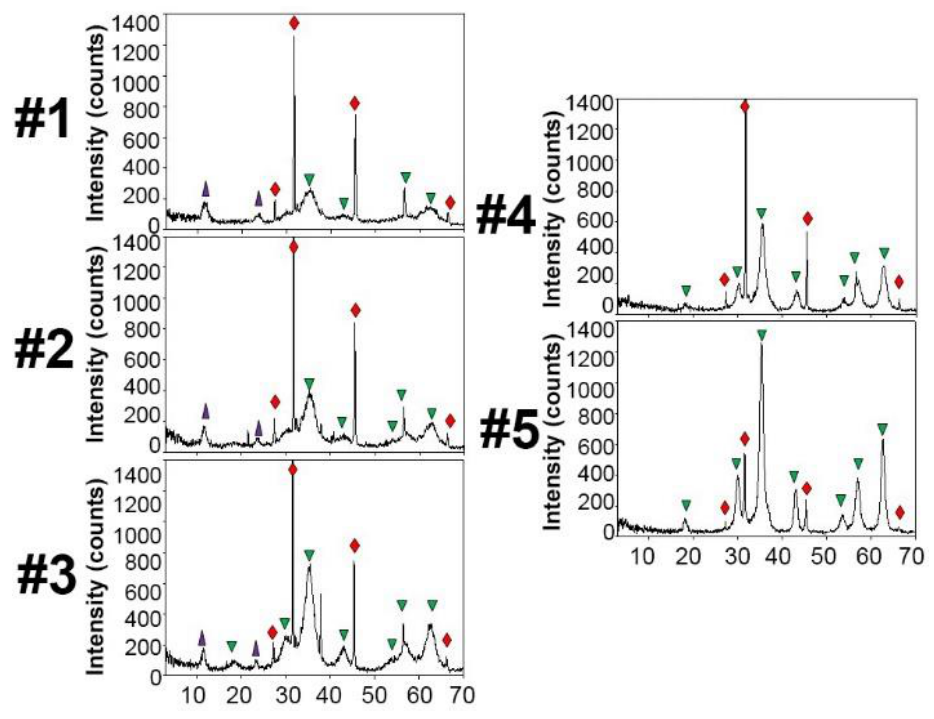
Figure 2. Powder X-ray diffraction (PXRD) patterns of samples #1–5. (MgAC), (NaCl halite, JCPDS-00-005-0628; JCPDS: Joint Committee on Power Diffraction Standard), and (Fe 3 O 4 magnetite, JCPDS-00-019-0629). Table 1. Elemental compositions (wt. %) of as-prepared samples by X-ray fluorescence (XRF) spectrometry. Sample #1